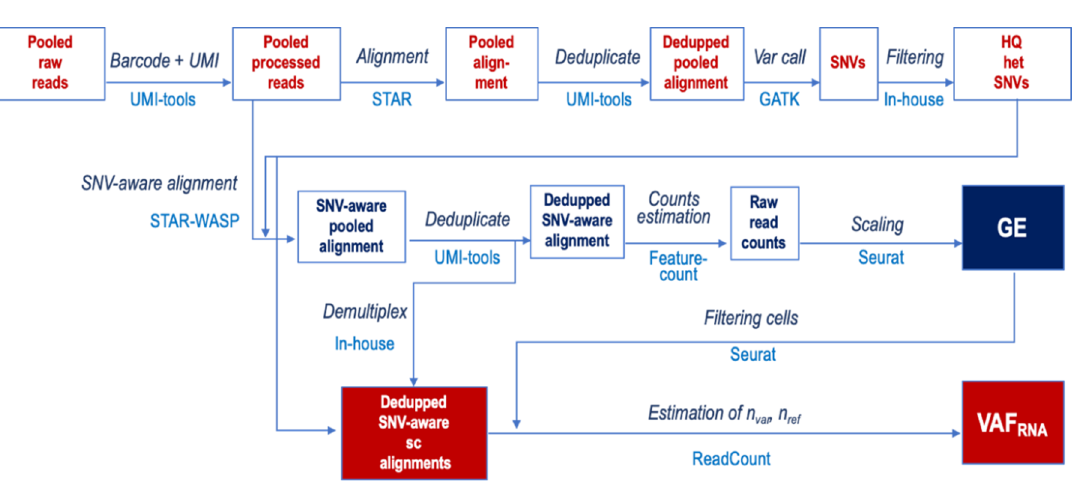
Figure 1. Analytical workflow for an estimation of the variant allele fraction VAF RNA from single-cell RNA-sequencing (sc-RNA-seq) data.